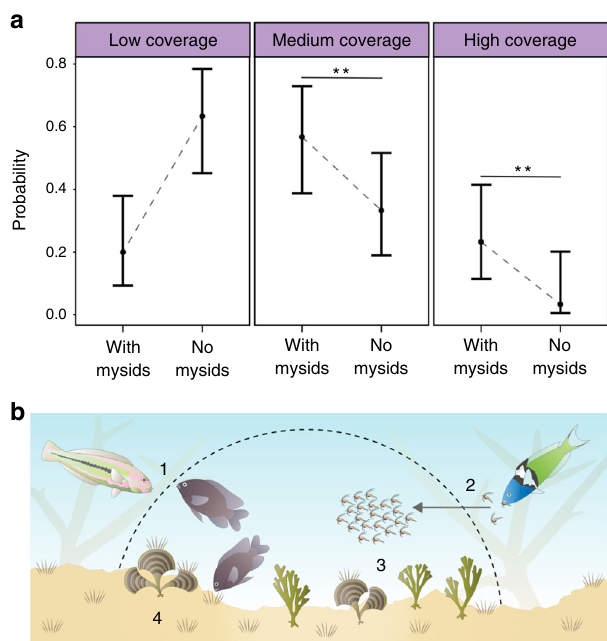
Fig. 4 Effect of mysids on farmed algae and overview of damsel fi sh- mysid relationship. ( a ) The impact of mysid presence on the predicted probabilities (model predicted probabilities ±95% con fi dence intervals) of low (<10%), medium (10 – 30%), and high (>30%) brown algae (Ochrophyta) coverage in long fi n damsel fi sh farms. Farms with associated mysids ( n = 30) were more likely to have medium ( P = 0.004) or high ( P = 0.005) coverage than farms without associated mysids ( n = 30) based on a multinomial logistic regression model (see Table S3). Asterisks indicate signi fi cant differences ( P < 0.05 = *, P < 0.01 = **, P < 0.001 = ***). ( b ) The damsel fi sh-mysid relationship, where (1) the niche created by the territorial, algae farming long fi n damsel fi sh provides (2) a protective refuge to mysids, leading to (3) increased survival. In turn, mysids provide (4) a predictable supply of nutrients, enriching the algae community and thus the quality of food available for damsel fi